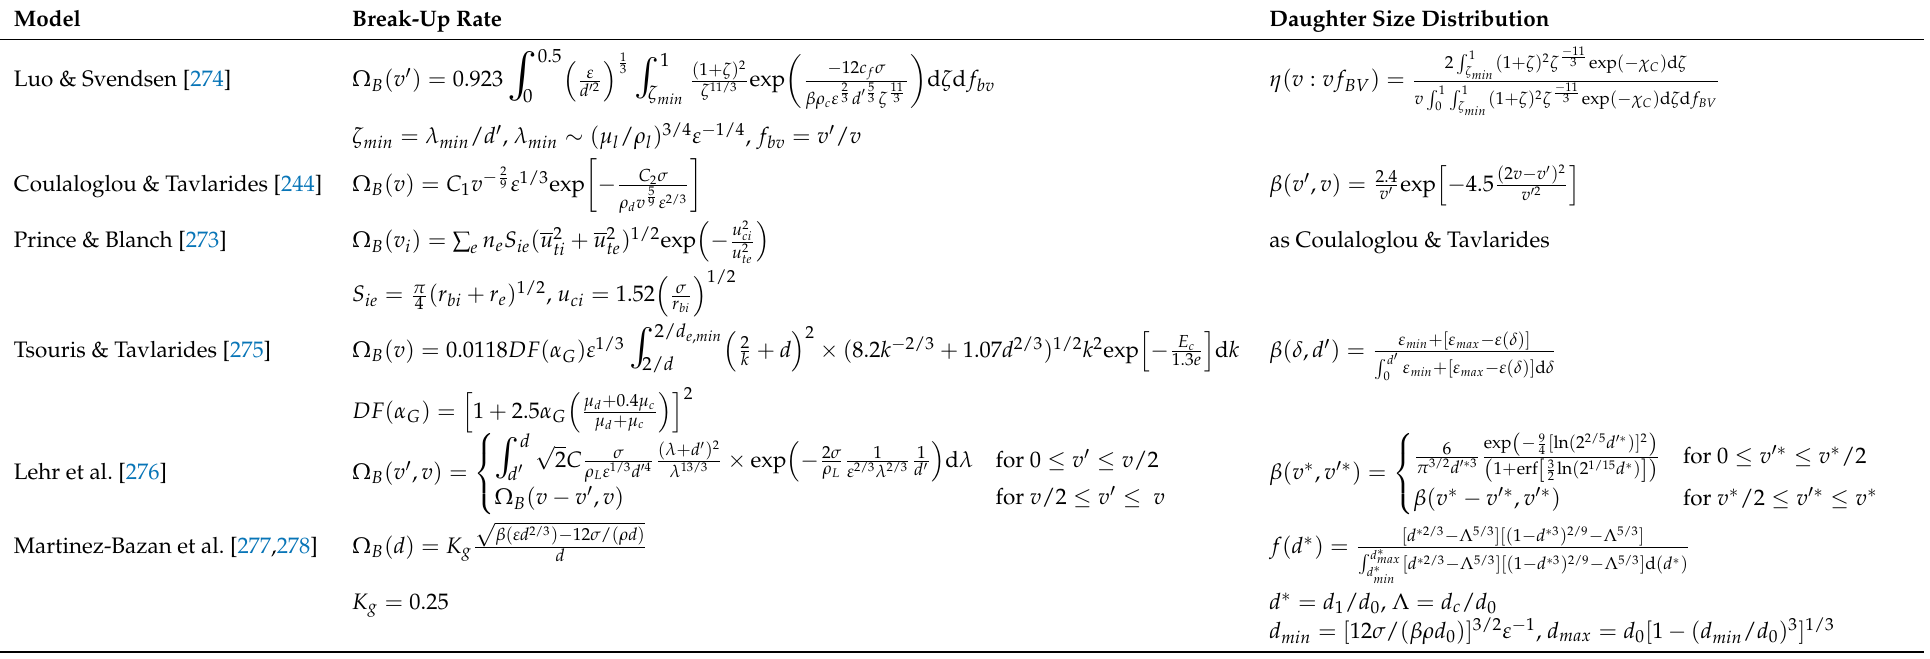
Table 11. Overview on selected break-up models for population balance